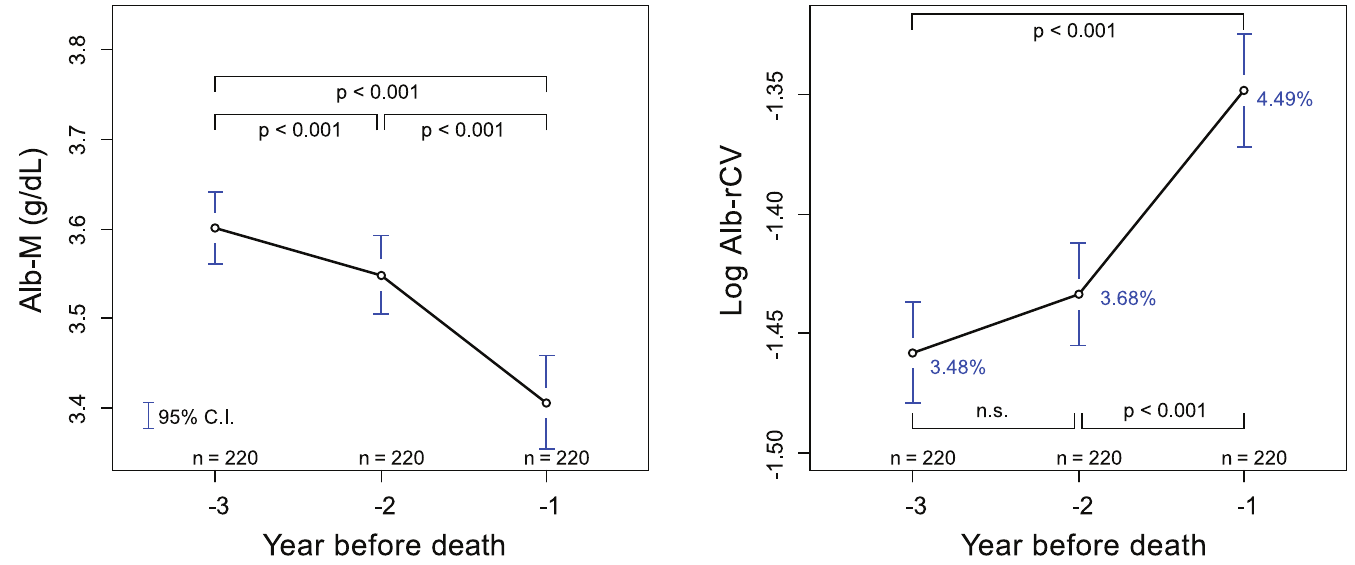
Fig 6. Annual comparison of Alb-M and Alb-rCV levels for the last 3 yearsbefore death. Among the before death subcohort, 220 patients who had survived and undergone continuousHD treatment at one of the study facilities for more than 3 years were selected. The mean Alb-M or log Alb-rCV values were then plotted for the year before death, and the statistical difference was examinedusing pairwisedependentt-test with Holm’s adjustment. The percentages written in blue are rCV values equivalent to a mean log Alb-rCV.